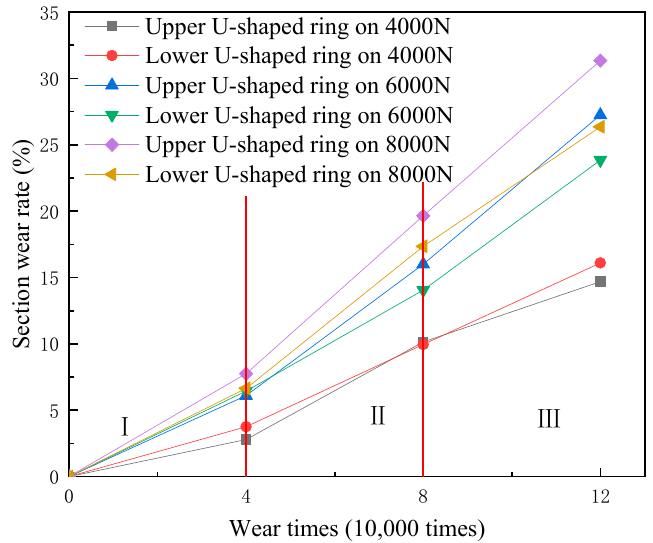
Figure 2. Change graph of wear rate of the upper and lower U-shaped ring sections with wear times.